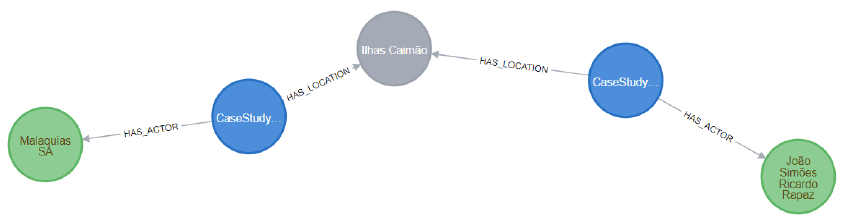
Figure 10. Cypher Query Output (Question